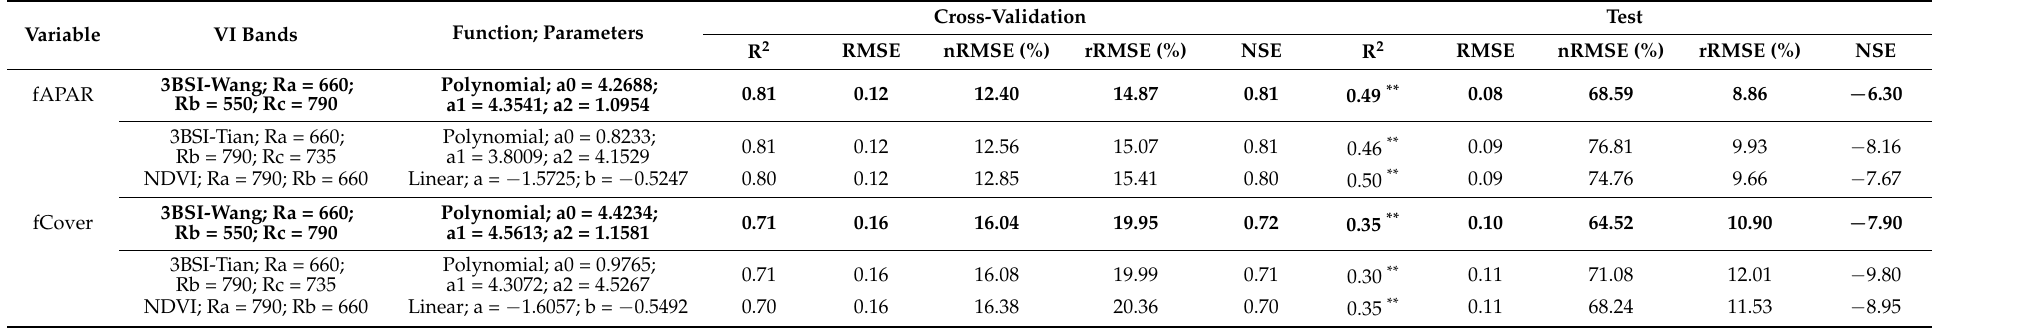
Table 9. Results of biophysical variables retrieval with parametric models, n_training = 260, n_test = 47. Levels of significance: ns. not significant; * p < 0.05; ** p < 0.01. The best performing models for each variable are in